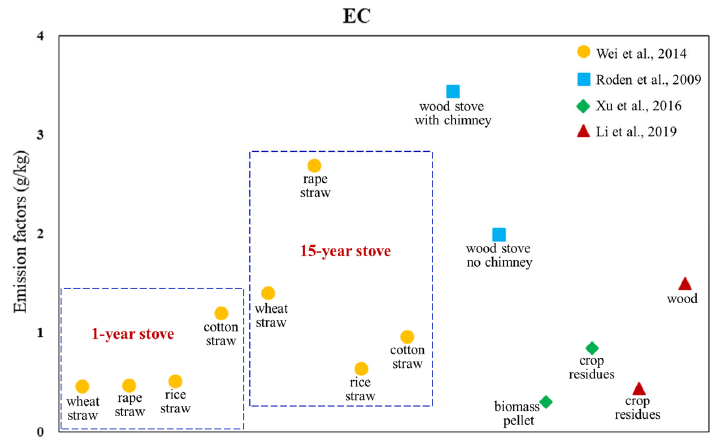
Figure 3. Emission factors of EC